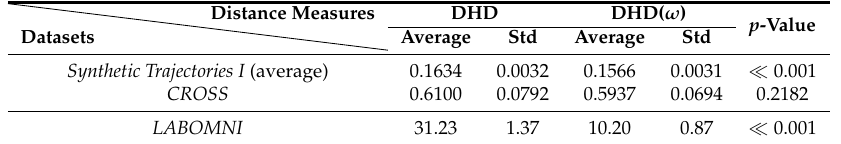
Table 2. Classification Error Ratio (%) on Different Trajectory Datasets and the corresponding p -value. Datasets